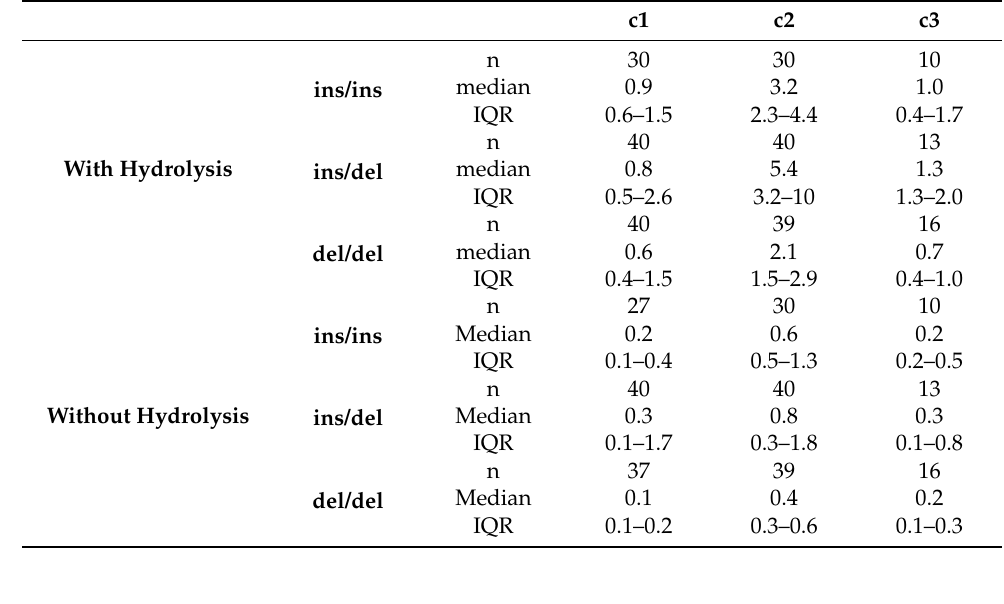
Table 1. Descriptive analysis of the number of urine samples analyzed by AR CALUX ® , including median and the interquartile range (IQR) of the androgenic response (DHT equivalent), with and without hydrolysis, for samples collected during the periods C1, C2, and C3.